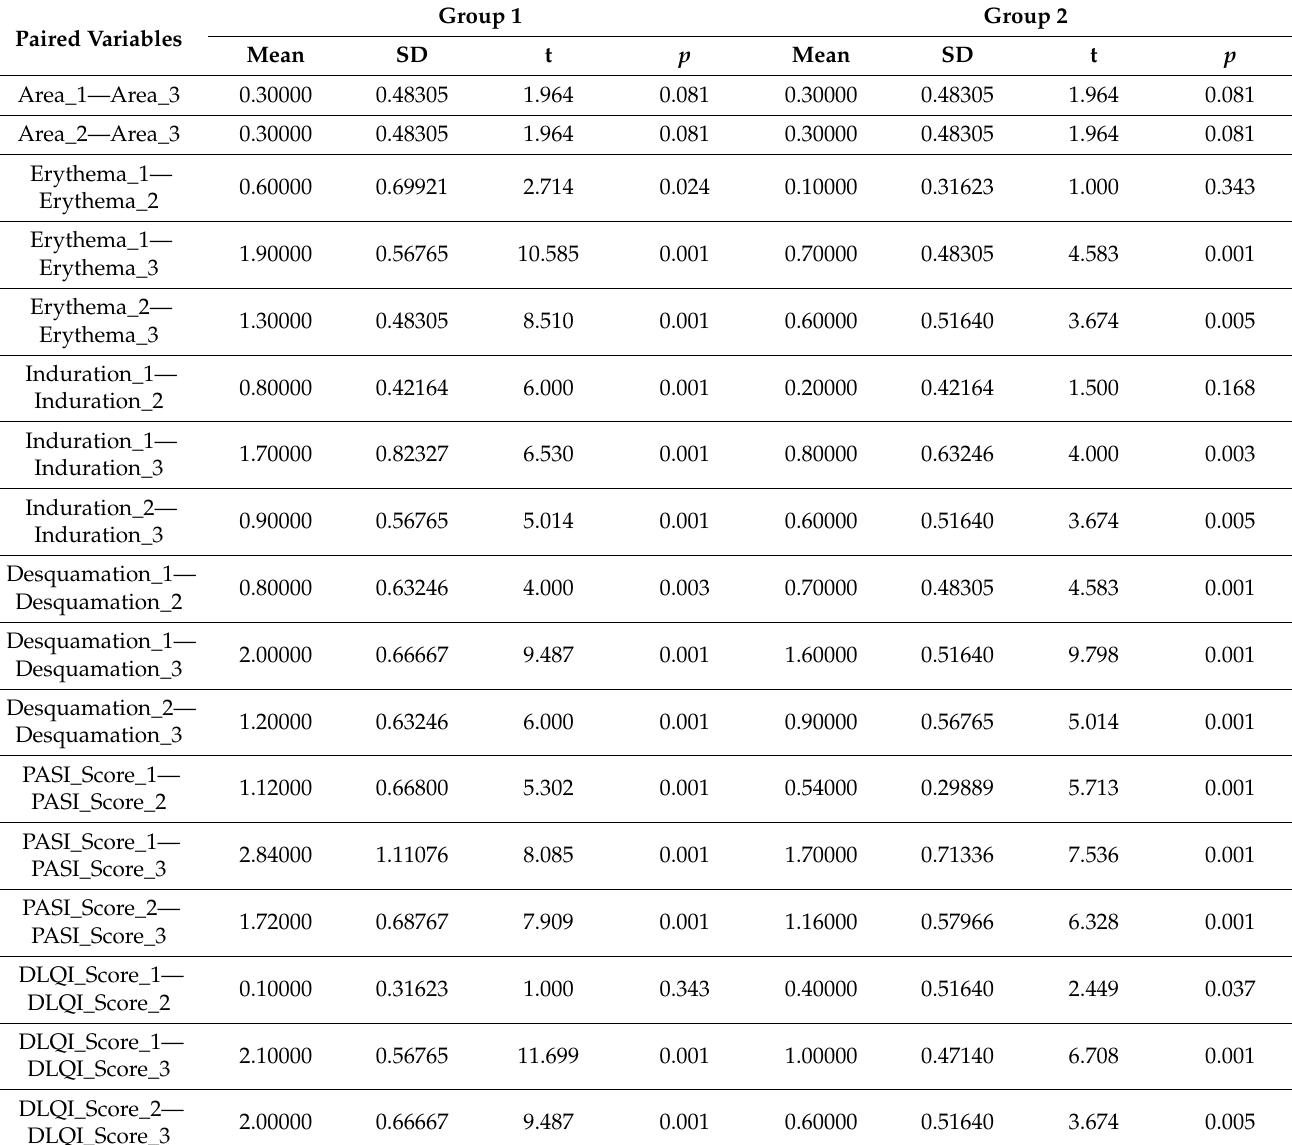
Table 4. Comparative statistics by the paired samples test method of the research